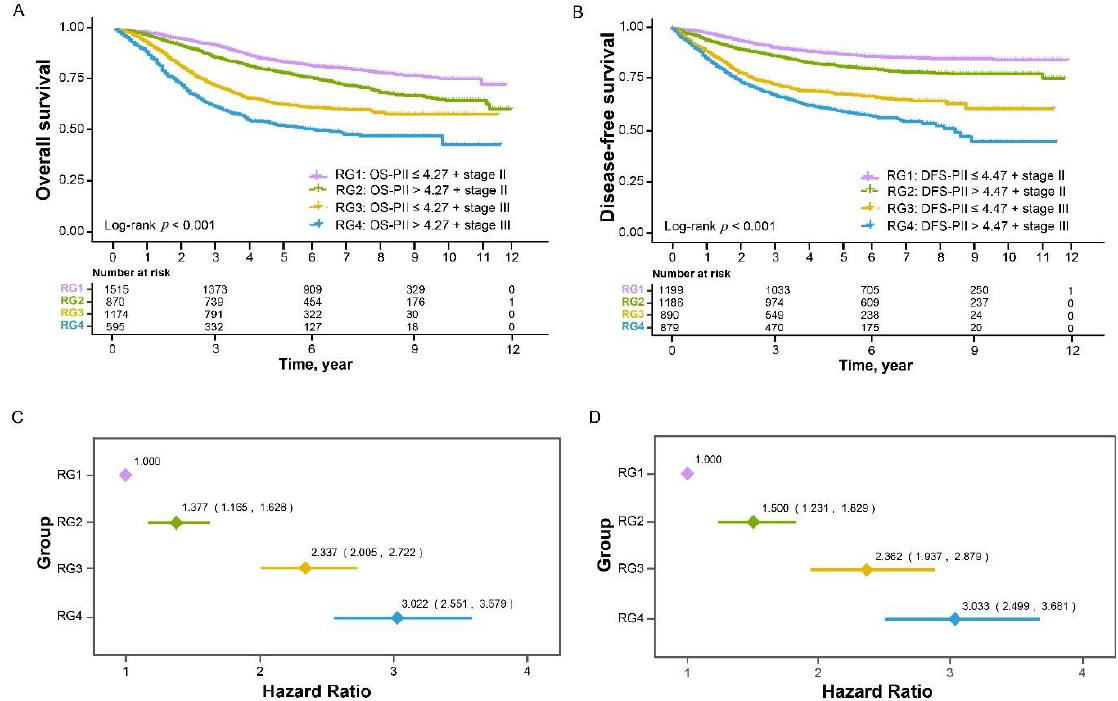
Figure 2. Risk stratification combining PIIs and TNM staging in relation to overall survival and disease-free survival of CRC in the training cohort. Kaplan–Meier curves of four risk groups for overall survival ( A ) and disease-free survival ( B ). Multivariate Cox analyses of the four risk groups for overall survival ( C ) and disease-free survival ( D ), adjusting for the significant clinicopathological factors in relation to overall survival (Table 2) and disease-free survival (Table 3).